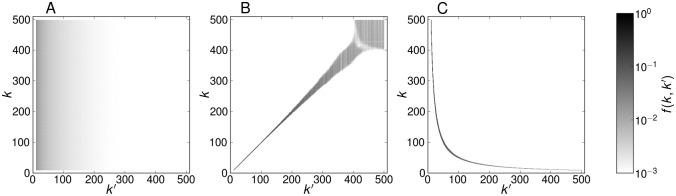
Probability f(k, k′) for a random input of a k-neuron to originate from a k′-neuron, sampled from the adjacency matrices of simulations with N = 105.Normalization demands ∑k′
f(k, k′) = 1. (A) Uncorrelated network, (B) assortative network, (C) disassortative network. The corresponding Pearson coefficients are p = −0.004 (uncorrelated); p = 0.997 (assortative); p = −0.662 (disassortative).